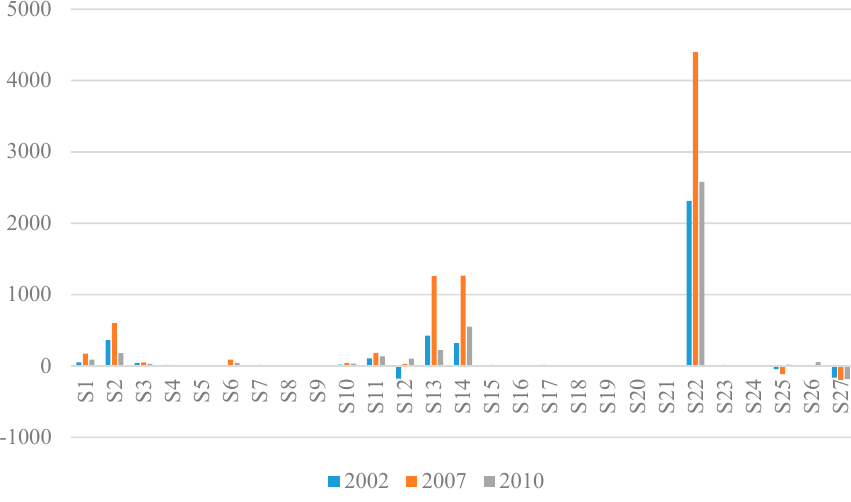
Figure 6. Net embodied carbon flowed in Beijing for industries in 2002, 2007, and 2010 (10 thousand tons).